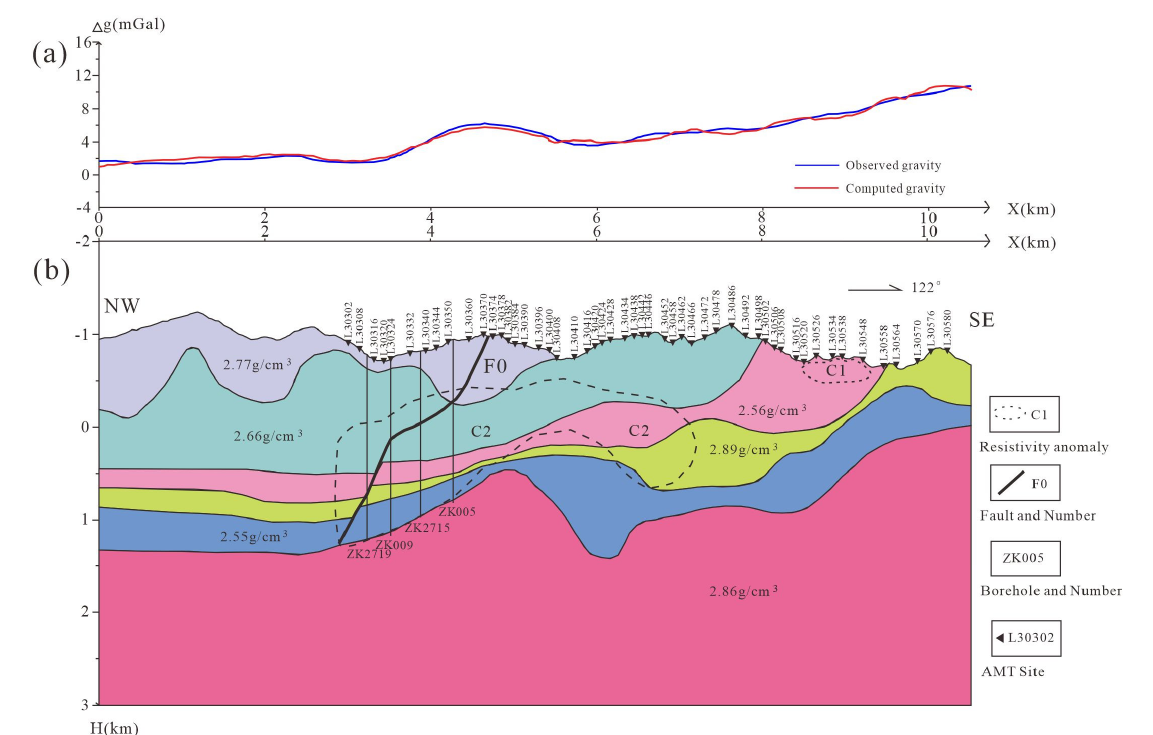
Figure 6. ( a ) Observed gravity curve and computed gravity curve. ( b ) The gravity density model of 2D interactive inver- sion.